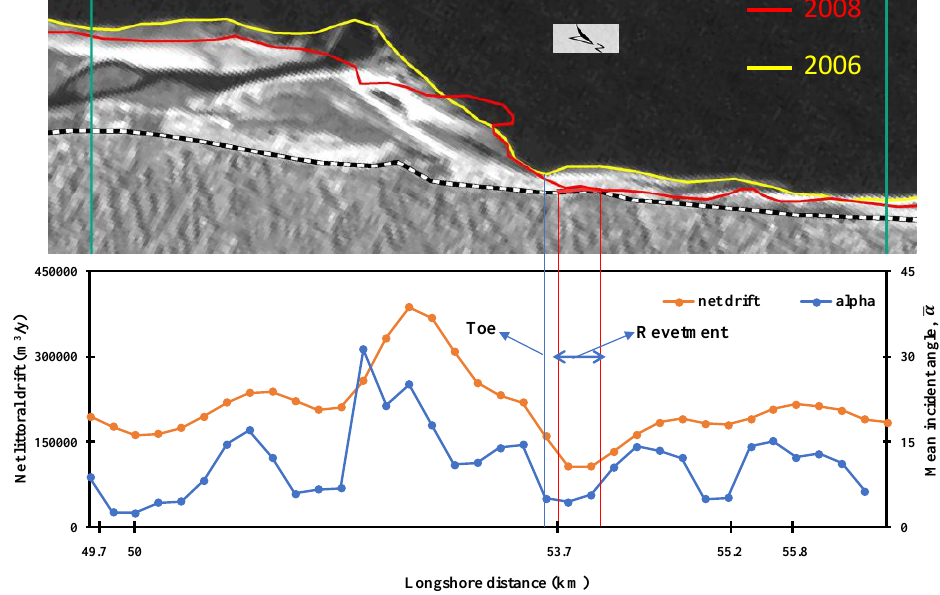
Figure 24. Distribution of the local wave incident angle and net littoral drift along the spit during 2006–2008.